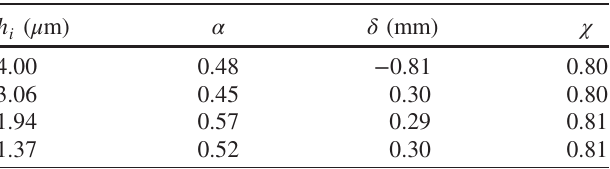
TABLE IV. Summary of fitted